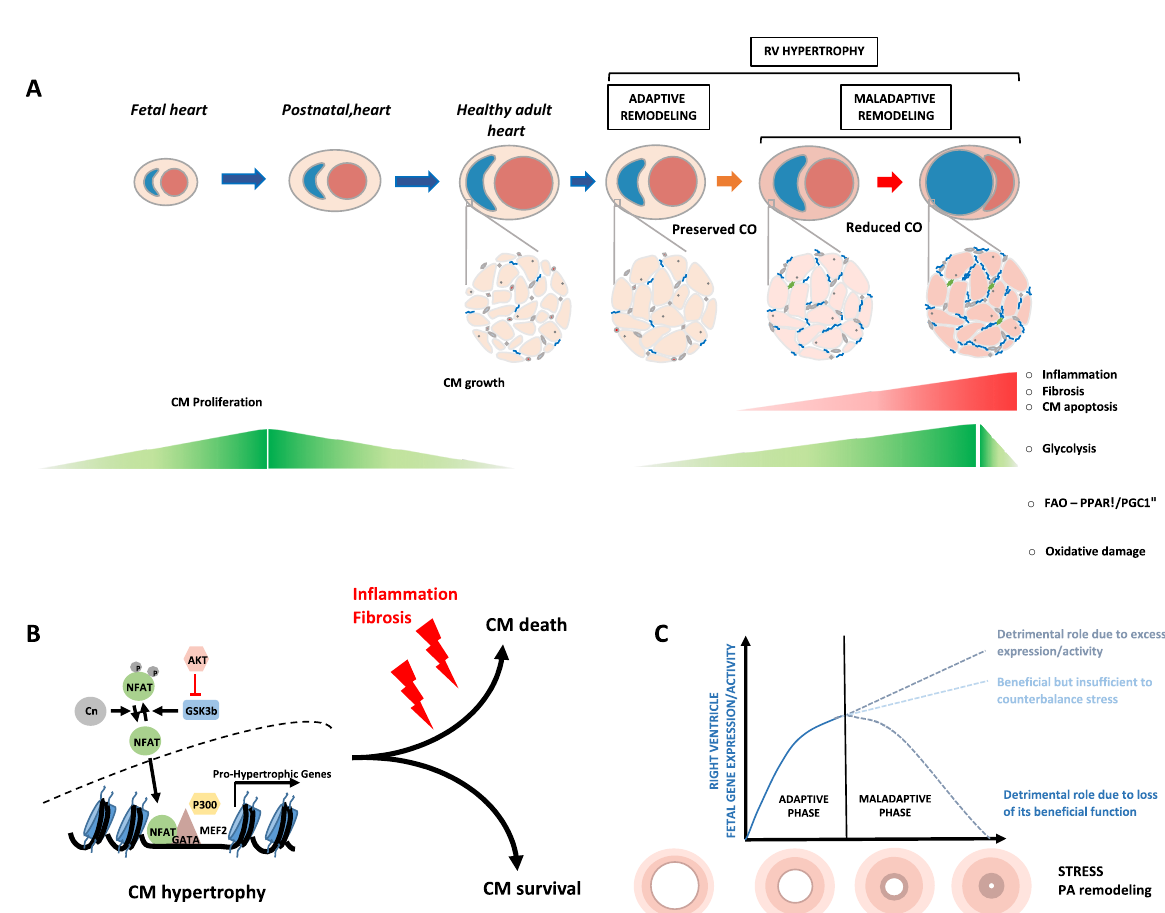
Figure 1. Relationships between cardiac development and RV remodeling. ( A ) During lung morphogenesis, proliferating cardiomyocytes (CMs) are primarily reliant on glycolysis for energy production. At least in part driven by the hypoxic to normoxic transition at birth, a metabolic switch from glycolysis to fatty acid oxidation occurs contributing to a gradual loss of CM proliferative capacity and their enhanced maturation. In response to stress, such as increase pulmonary artery pressure, cardiomyocytes experience cellular and molecular changes to mitigate wall stress including a hypertrophic growth with a reactivation of a fetal metabolic profile (preference of carbohydrates over fatty acids as substrates for energy) and re-expression of contractile proteins normally present in embryonic CMs. At the early stages, these structural changes exert a compensatory mechanism that maintain cardiac output (CO) and preserve RV function. However, these adaptive mechanisms no longer suffice and become overwhelmed by biomechanical stress, thereby resulting in enhanced oxidative stress, inflammation, and fibrosis, which culminates in electrophysiological changes/contractile dysfunction, loss of CMs and RV failure. ( B ) Simplified scheme of key factors initially engaged in the execution of CM hypertrophic response. Persistent and excessive stress impacts this initially adaptive core program (post-transcriptional modifications, isoform switching, distinct transcription factor combinations...) leading to its bifurcation to a maladaptive mode (failing CM). ( C ) Proposed model in which reactivation of fetal genes exerts either salutary or detrimental effects in function of their expression levels and stress